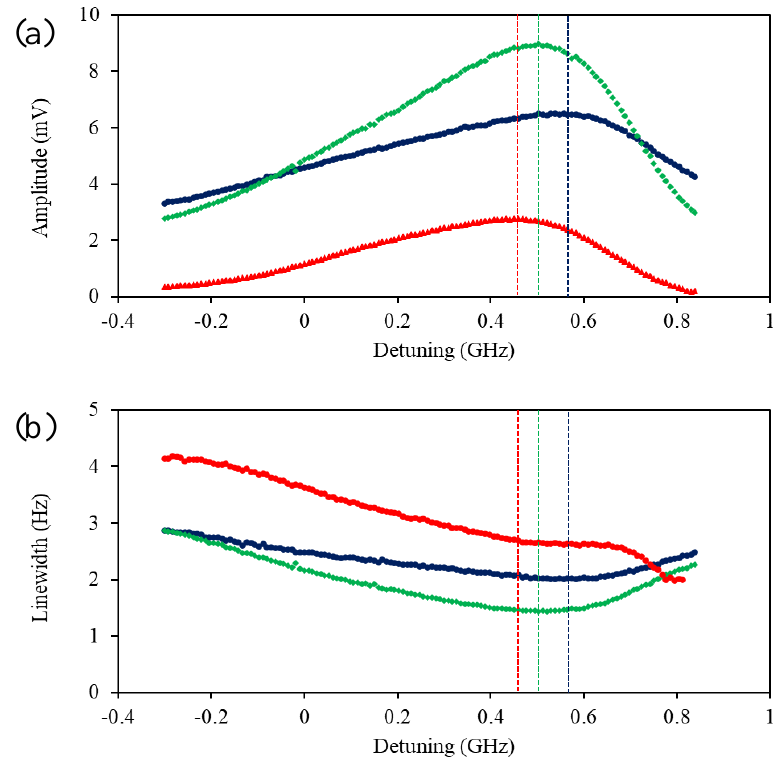
Figure 7. The amplitude ( a ) and the linewidth ( b ) of the rf spectrum profile as a function of laser detuning in the degenerate pump and probe beam configuration recorded for the pump beam power of 4.83mW (blue dots), 1.169mW (green squares), and 0.067mW (red triangles).